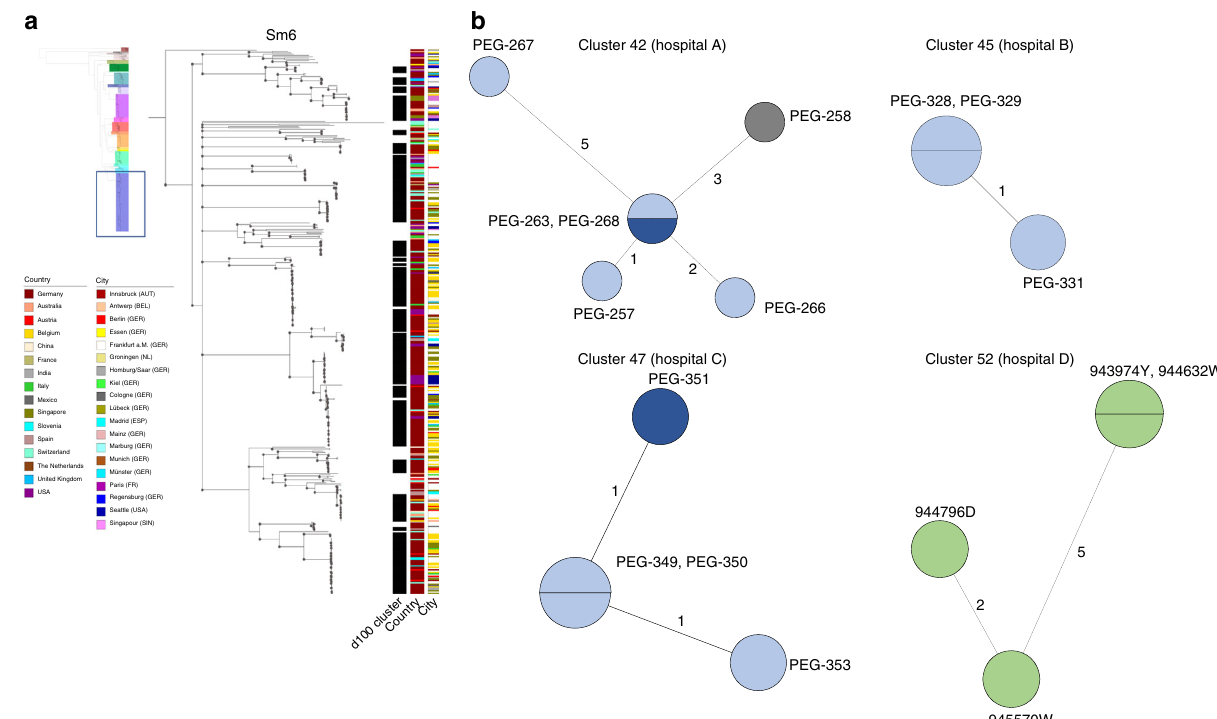
Fig. 5 Analysis of d100 clusters in lineage Sm6 and closely related d10 clusters across the study collection. a The d100 clusters in the largest human- associated lineage Sm6 consist of strains from various countries and, for strains from the same country, of various cities. The coloured bars represent, from left to right, the d100 clonal complexes, the country of isolation, and the city of isolation. b High-resolution analysis of four selected d10 allele clusters for which detailed metadata, i.e. day, source and ward of isolation, was available are shown as minimum spanning trees based on the 100% core genome MLST loci of the respective cluster. The number of loci used were 3734 for cluster 42 (hospital A), 4190 for cluster 45 (hospital B), 3637 for cluster 47 (hospital C) and 3714 for cluster 52 (hospital D). The number of mismatched alleles are shown in small numbers on the connecting branches. Node colours indicate isolation source, light blue = respiratory sample, dark blue = sputum, grey = wound swap, green = endoscope. Source data are provided as Source Data Files.